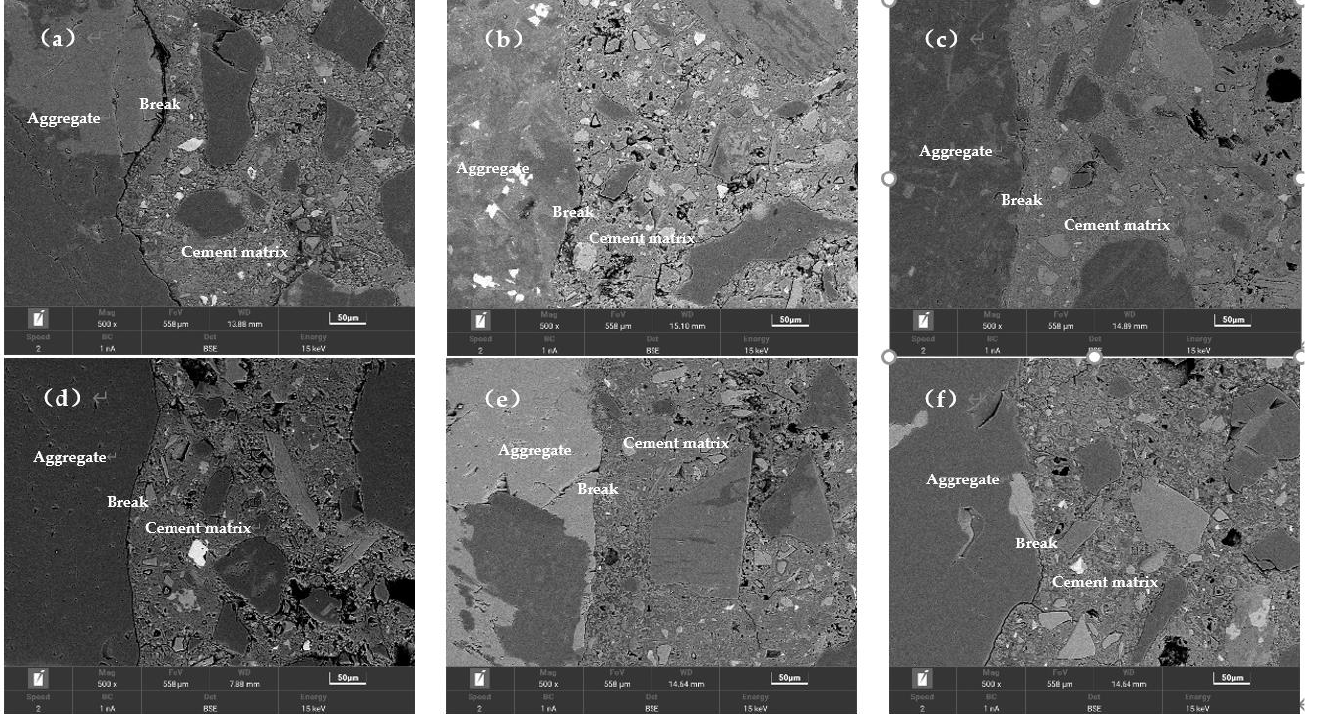
Figure 11. Identified BSE images of samples at 28-d of ( a ) G0, ( b ) G1.5, ( c ) G2, ( d ) C0, ( e ) C20, and ( f ) C30. To quantify the unhydrated particles and porosity near the transition zone at the interface of different concrete specimens, strip segmentation, and threshold segmentation were performed for the area within 100 µ m of the aggregate, starting from the surface of the aggregate particles. The porosity and the percentage of the area corresponding to the unhydrated particles were determined for each segment using 5 µ m as a section [55,56]. The result of the calculation is shown in Figures 12 and